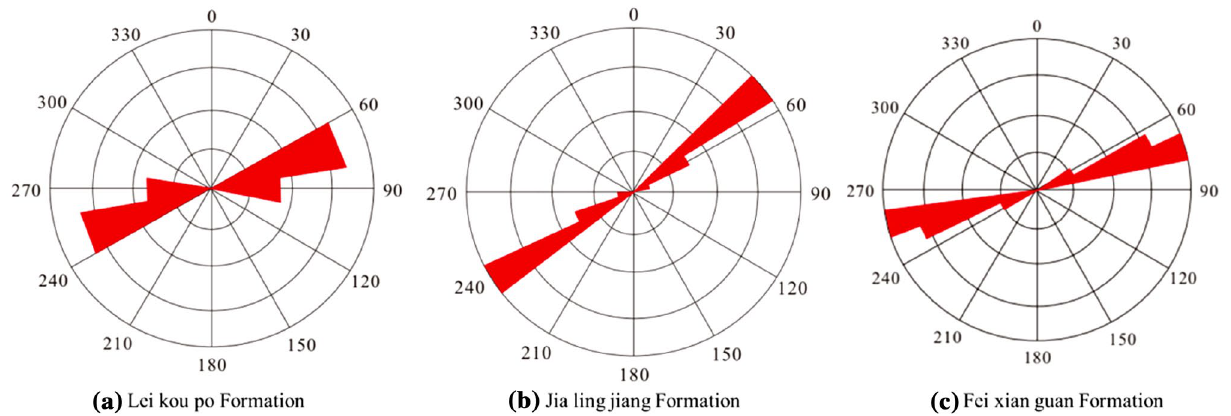
Fig. 14 Direction of horizontal principal stress in marine carbonate formations